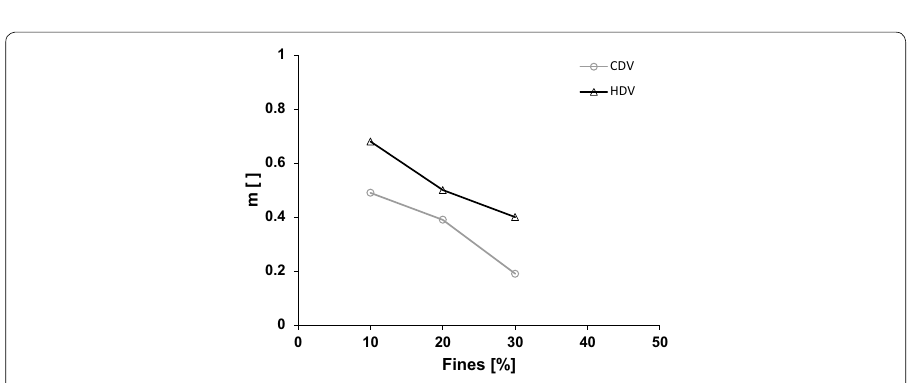
Fig. 9 Variation of degree of convergence with fines